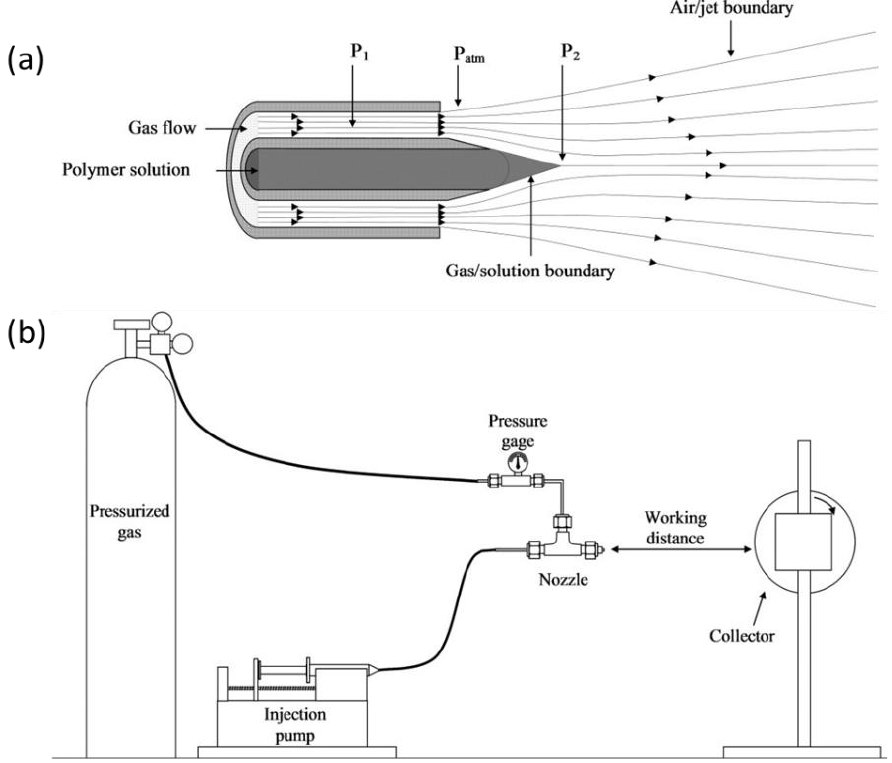
Figure 20. Bandage-like fibrous scaffold fabrication ( a ) simple centrifugal spinning system; ( b ) im- Figure 20. Solution blowing nanofibre system; ( a ) concentric design of nozzle used in SBS. ( b ) SBS age of the prepared sample as wrapped around an arm. Reproduced with permission from ref. [165]. set-up with a rotating collector. Reproduced with permission from [165], copyright 2020 Elsevier. Copyright 2019 MDPI.